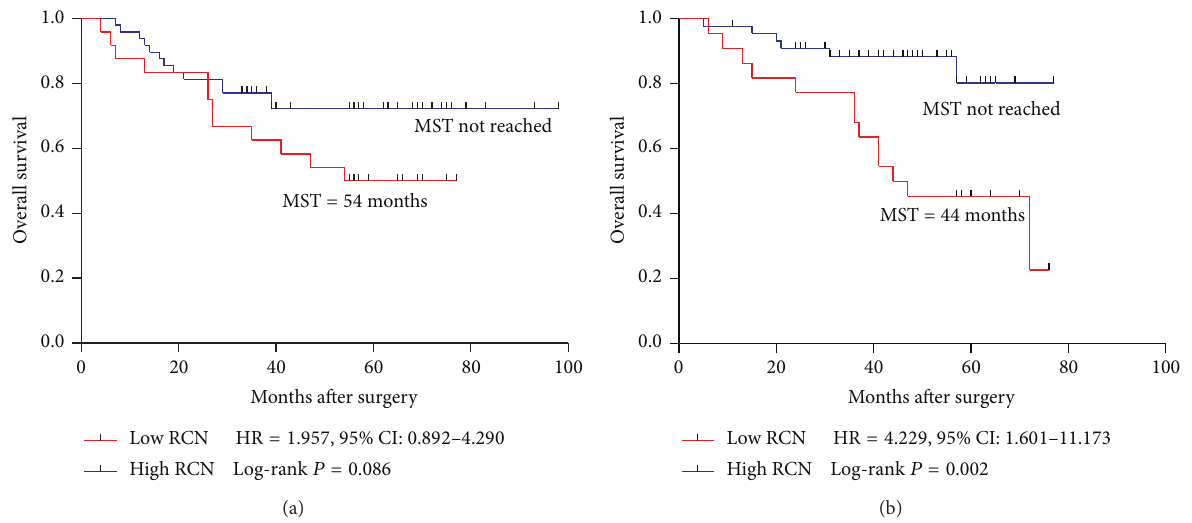
Figure 4: Kaplan-Meier survival curves of patients with stage III, IIIB, and IIIC disease receiving oxaliplatin-based chemotherapy. (a) OS in colon; (b) OS in rectum. MST: median survival